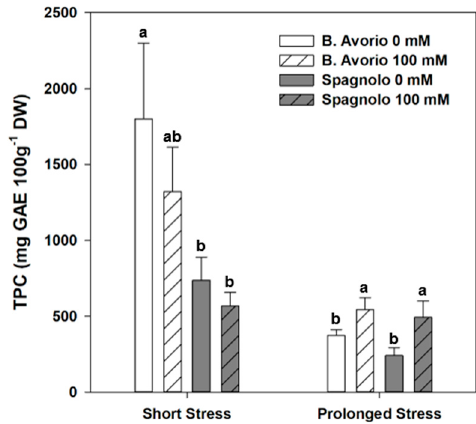
Figure 2. Total phenolics content (TPC) in leaves of “Bianco Avorio” and “Spagnolo” genotypes of C. cardunculus var altilis after 2 and 21 days of 0 (control) and 100 mM (salinity treatment) NaCl, expressed as gallic acid equivalents (GAE) and measured by the ABTS assay. Each value represents the mean ± SD of three biological replicates. Values indicated with di ff erent letters are significantly di ff erent between genotypes and treatments within the same sampling time at p < 0.05, by analysis of variance